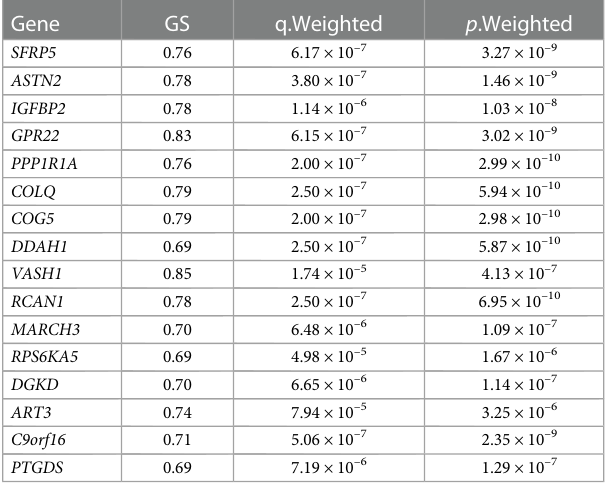
TABLE 1 Hub genes screened in the green module.